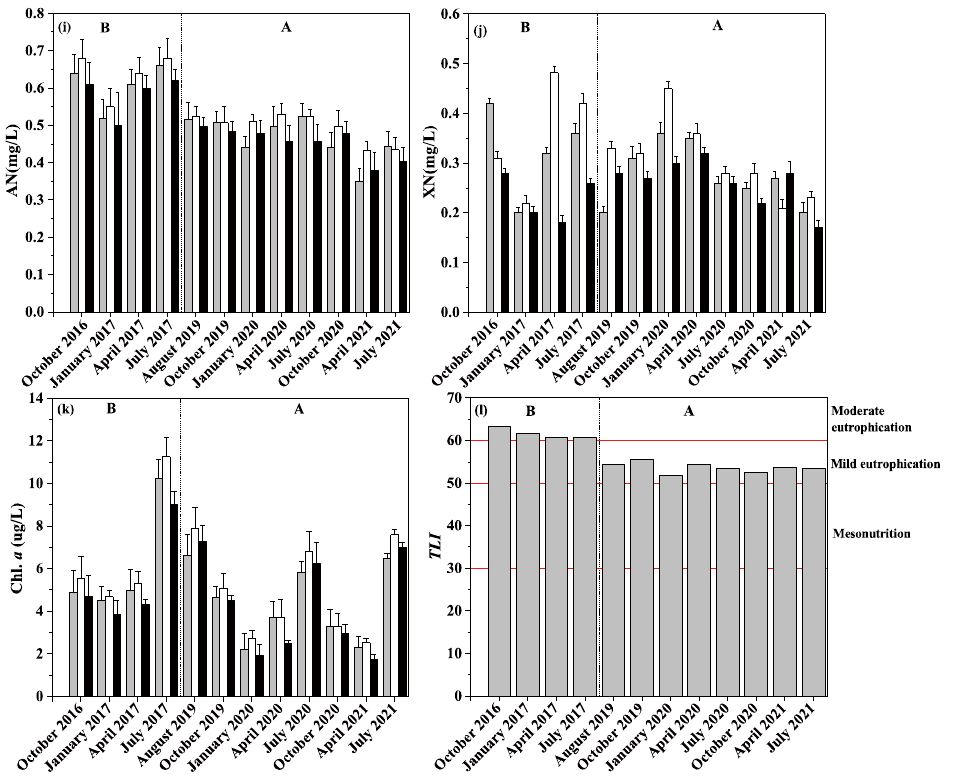
Figure 2. Spatial variation of different physical and chemical indices. Abbreviations was used in the diagram: ( a ) WT: water temperature, ( b ) WD: water depth, ( c ) pH, ( d ) SD: Secchi depth, ( e ) DO: dissolved oxygen, ( f )Turb: turbidity, ( g ) TP: total phosphorus, ( h ) TN: total nitrogen, ( i ) AN: ammonia nitrogen, ( j ) XN: nitrate nitrogen, ( k ) Chl. a : chlorophyll a , and ( l ) TLI : comprehensive nutrient status index. The capital letters B and A represent before and after the restoration of aquatic vegetation, respectively. Vertical lines separated the before (October 2016 to July 2017) and after (August 2019 to July 2021) restoration periods. The red lines distinguished nutrient levels, with TLI between 30 and 40 being mesonutrition, between 50 and 60 being mild eutrophication, and between 60 and 70 being moderate eutrophication.